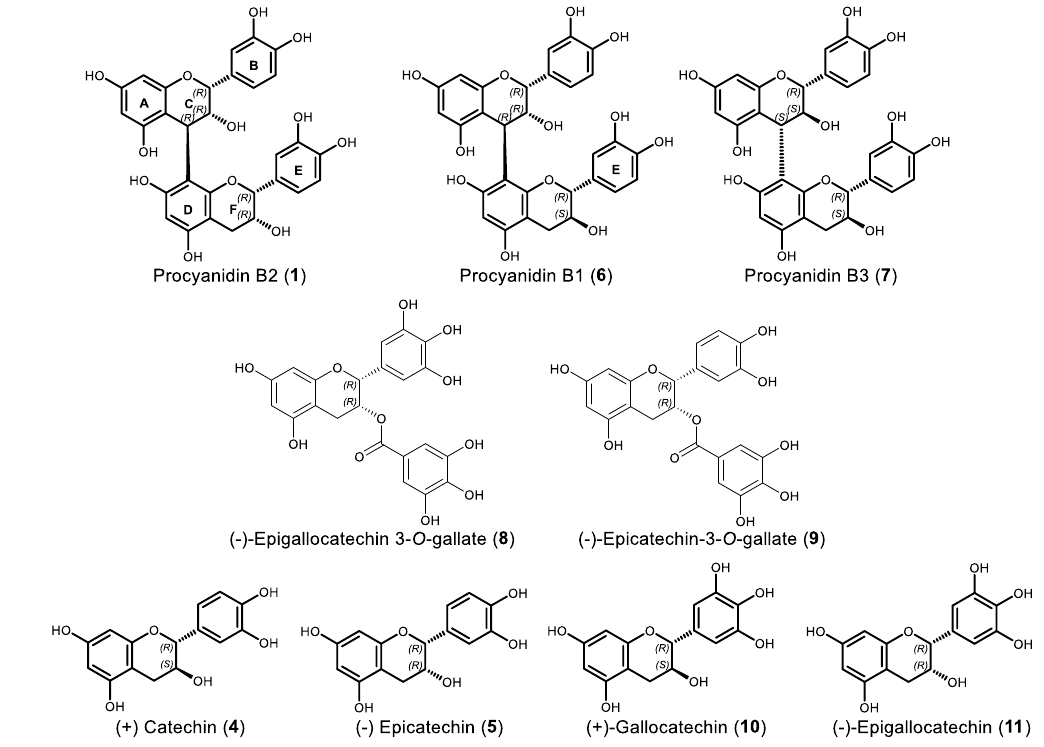
Figure 4. Chemical structures of compounds 1 , 4 , 5 , and 6 – 11 . Table 1. Antiviral and cytotoxic activities of procyanidins and flavan-3-ols a .